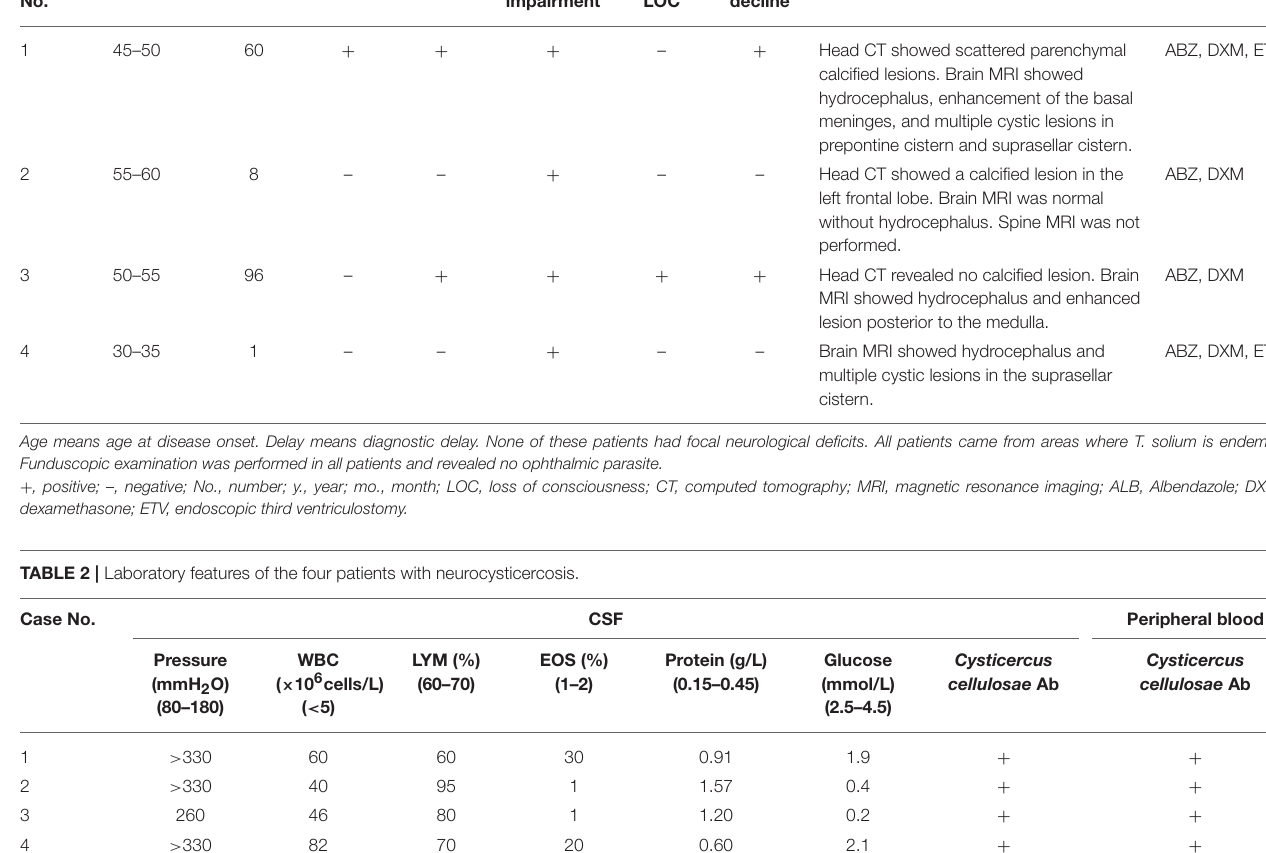
TABLE 1 | Clinical features of the four patients with neurocysticercosis. Case Age range, y. Delay, mo. Seizure Headache No.